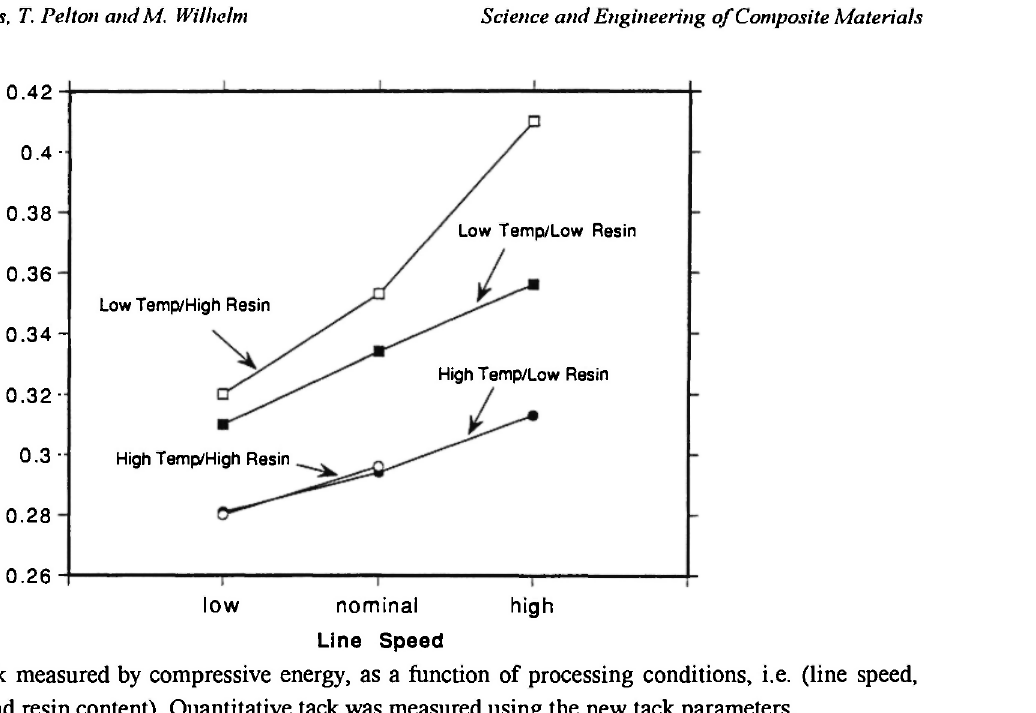
Qualitative tack measured by compressive energy, as a function of processing conditions, i.e. (line speed, temperature, and resin content). Quantitative tack was measured using the new tack parameters.